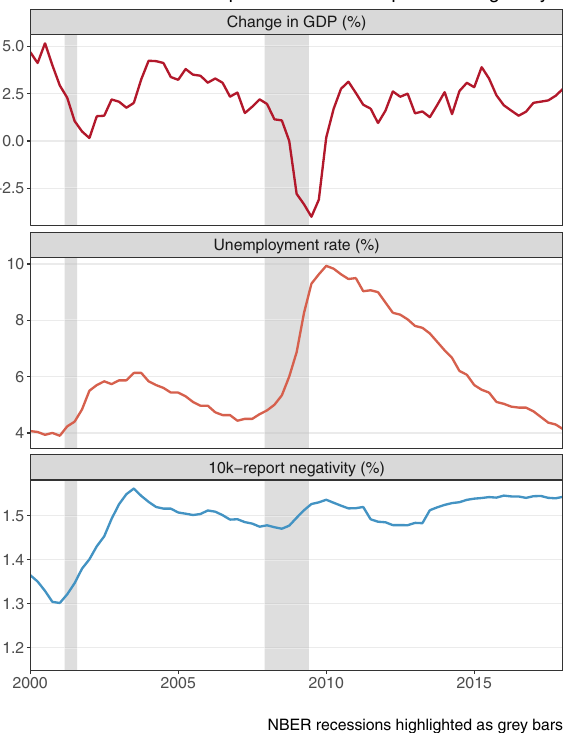
Fig. 9 Comparison of quarterly GDP change (upper panel), unemployment rates (central panel), and share of negative words in 10-K reports (lower panel). The fi gure exempli fi es that the sentiment of 10-K reports tend to correlate with overall macroeconomic